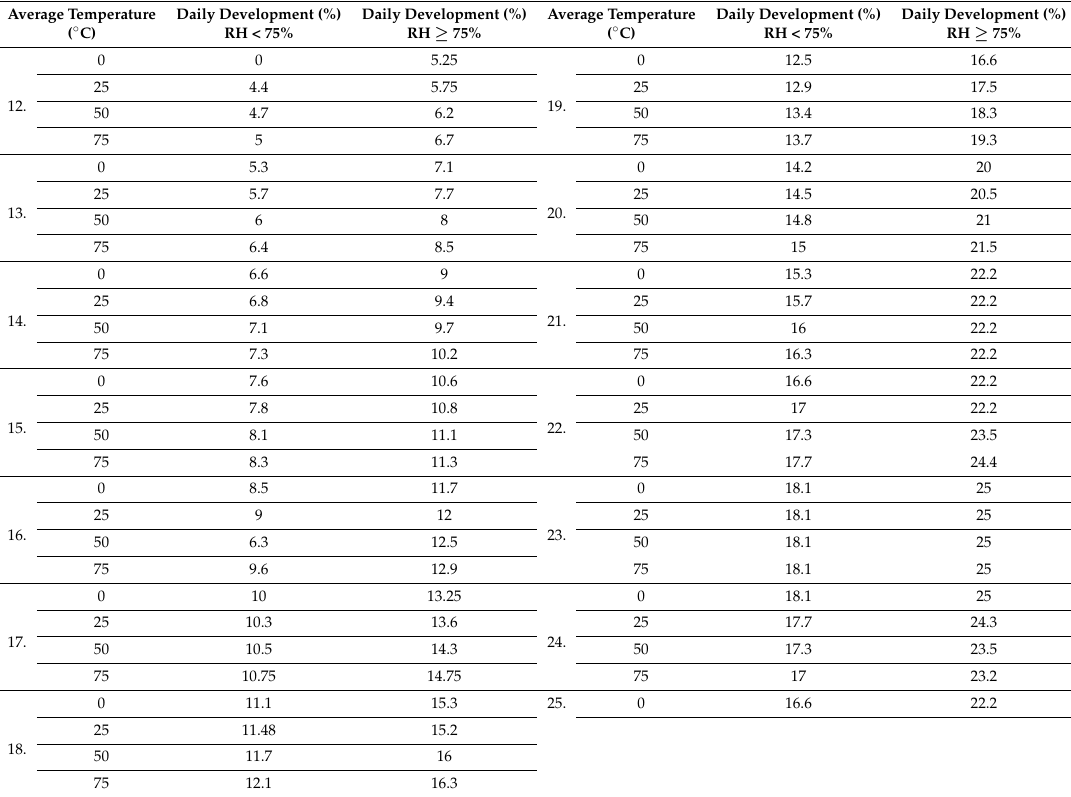
Table 1. Goidanich’s table for following the development of downy